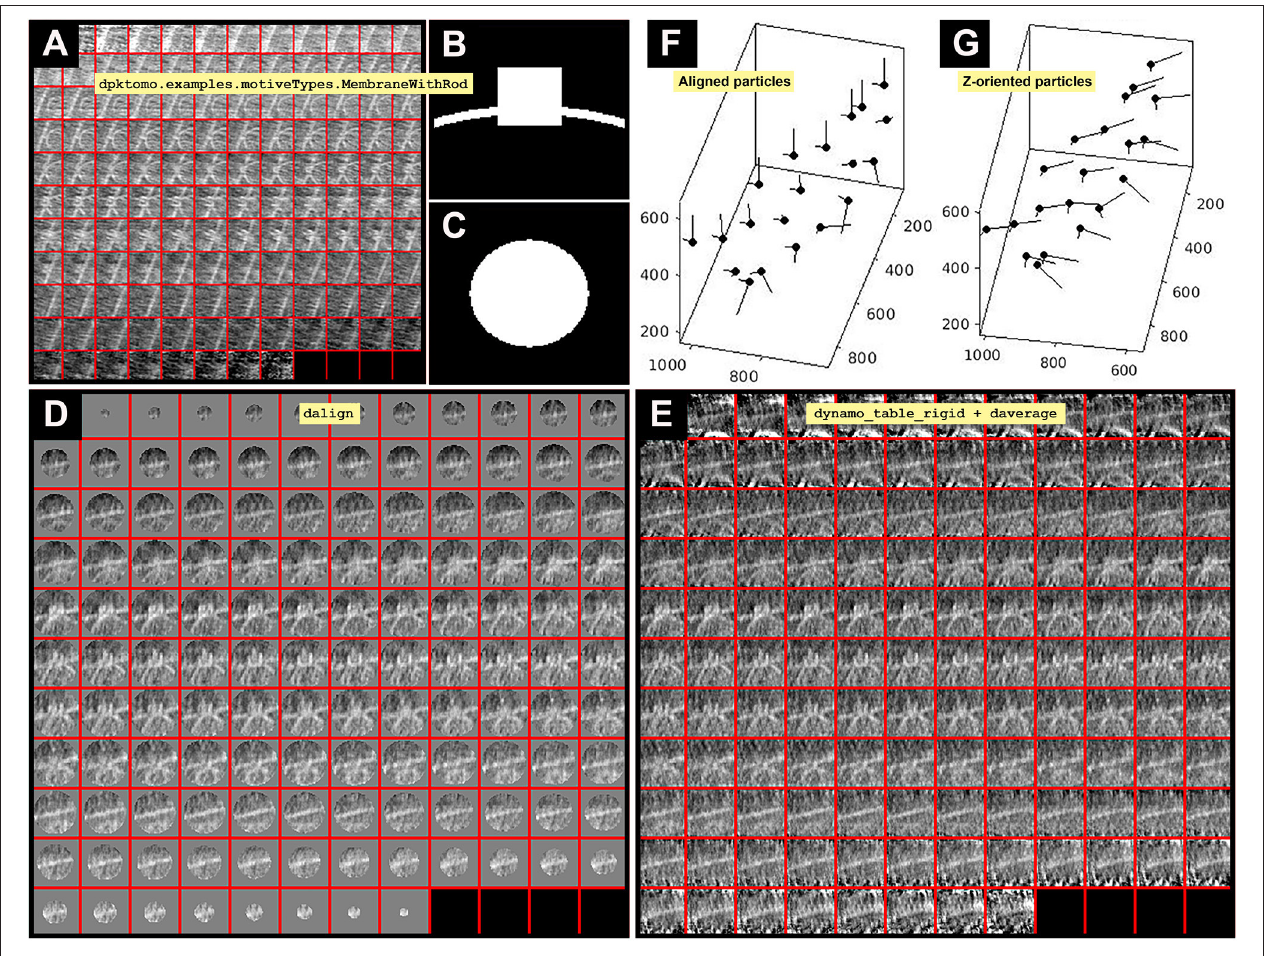
FIGURE 2 | Imparting orientation without geometrical information. (A) Slices along Y of the average obtained from project first is defined in the workspace as the variable previousAverage displayed in dview . (B) Y view of the mask (slice 64 in dmapview ) created by using dpktomo.examples.motiveTypes. MembraneWithRod . (C) Z view of the mask (slice 64 in dmapview ) created by using dpktomo.examples.motiveTypes. MembraneWithRod . (D) Result of applying the mask shown in (B) (Y view) and (C) (Z view) to the average shown in (A) (slices along Y of previousAverage ) by using dalign (slices along Y displayed in dview ). The output of dalign is contained in the object sal , which encloses geometrical information of the shifts resulting from the dalign command. (E) Result of applying the rectified table tr onto the particles shown in (D) (slices along Y) by using the dynamo_table_rigid command and averaging the particles (slices along Y displayed in dview ). The rectified table tr comes from applying the property inside the object sal (sal.Tp) to the table obtained from project first (tf) . (F) Graphical representation of the aligned particles (black dots) before applying the rectified table tr . (G) Graphical representation of the Z-oriented particles after applying the rectified Z-oriented table tr . The Z orientation computed for each particle is represented by the longest semiaxis.